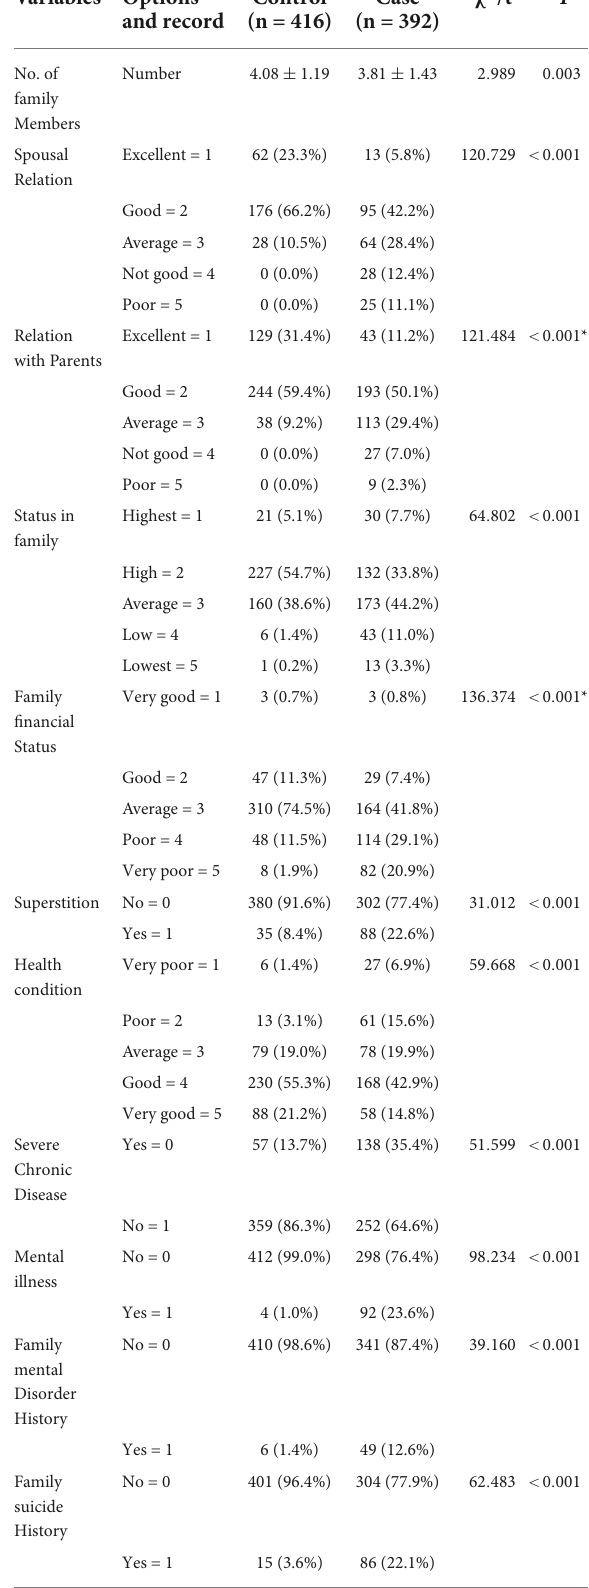
TABLE 1 The demographic variables of suicide case and control groups.